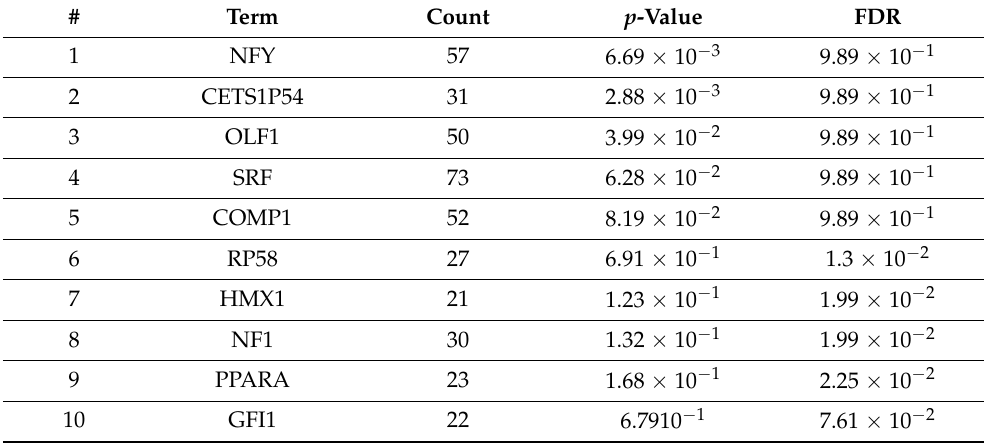
Figure 1. Identification of DEGs by volcano plot for PCa. Volcano plot for six GEO microarray datasets: ( A ): GSE46602, ( B ): GSE38241, ( C ): GSE69223, ( D ): GSE32571, ( E ): GSE55945, and ( F ): GSE26126. The criteria of DEGs cutoff standard are p -value < 0.05 and |log2FC| (fold change) > 1. Color code—gray: up-regulated genes; yellow: down-regulated genes; orange: no change in expression levels of DEGs; blue: non-DEGs). Table 1. UCSC_TFBS enrichment analyses showed TFs that putatively bind to the subsets of the genes by protein interactions option of the functional annotation tool of 109 up-regulated overlapping genes in